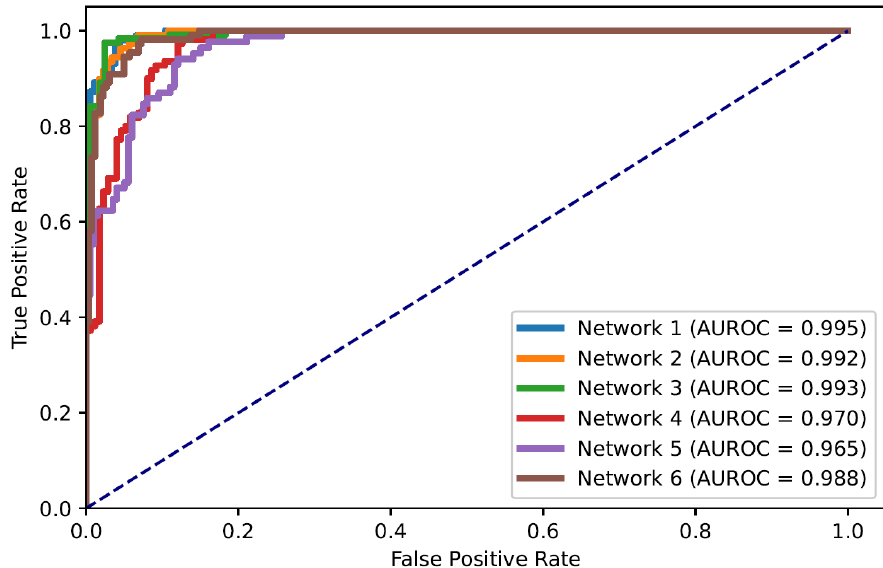
Figure 5. ROC curves for classification of lung quadrants regardless of their position in the